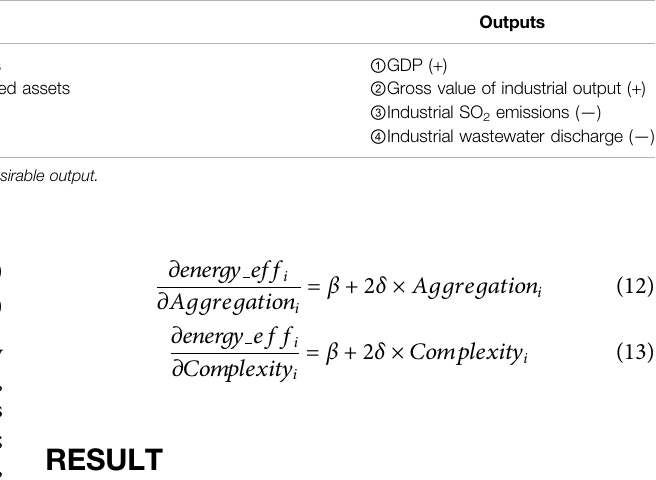
TABLE 1 | Input and output variables for energy ef fi ciency identi fi